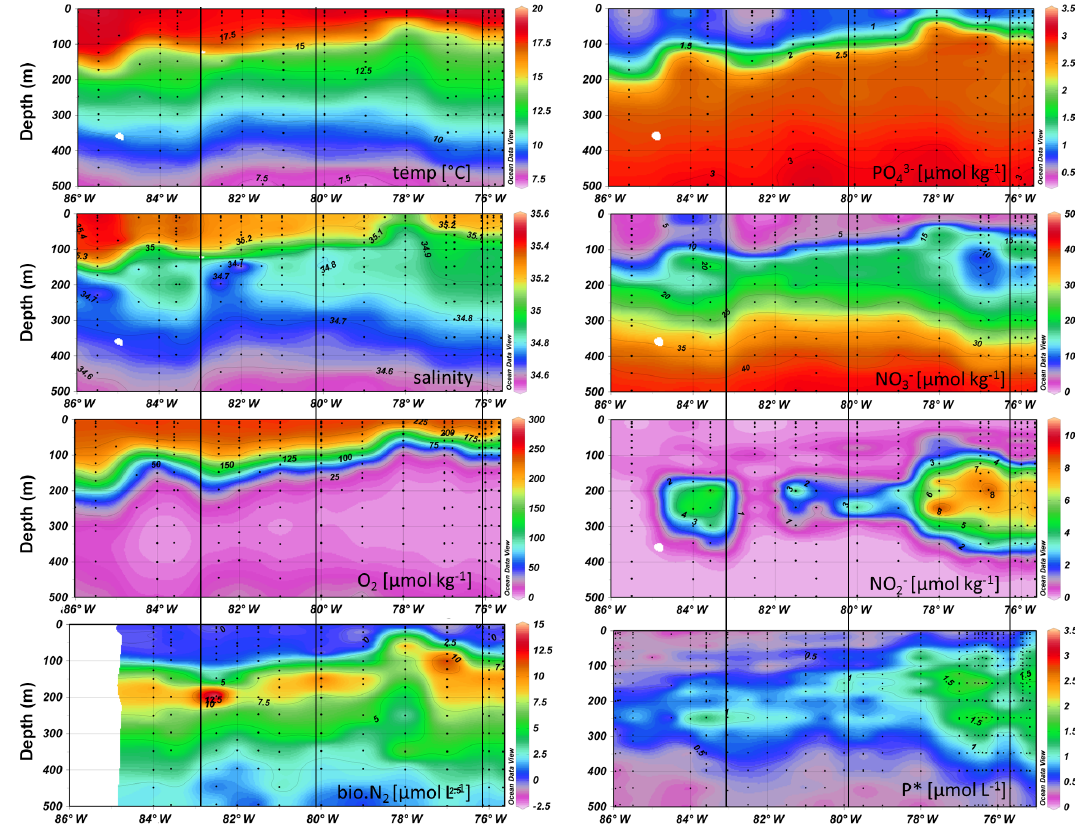
Figure 2. Temperature, salinity and oxygen, phosphate, nitrate, nitrite, biogenic N 2 , and P ∗ for eddies A, B and C along a cross section at 16 ◦ 45 (cid:48) S during the M90 cruise are shown. The black lines indicate the eddy centers at ∼ 76 ◦ W (eddy A), ∼ 80.1 ◦ W (eddy C) and ∼ 83.3 ◦ W (eddy